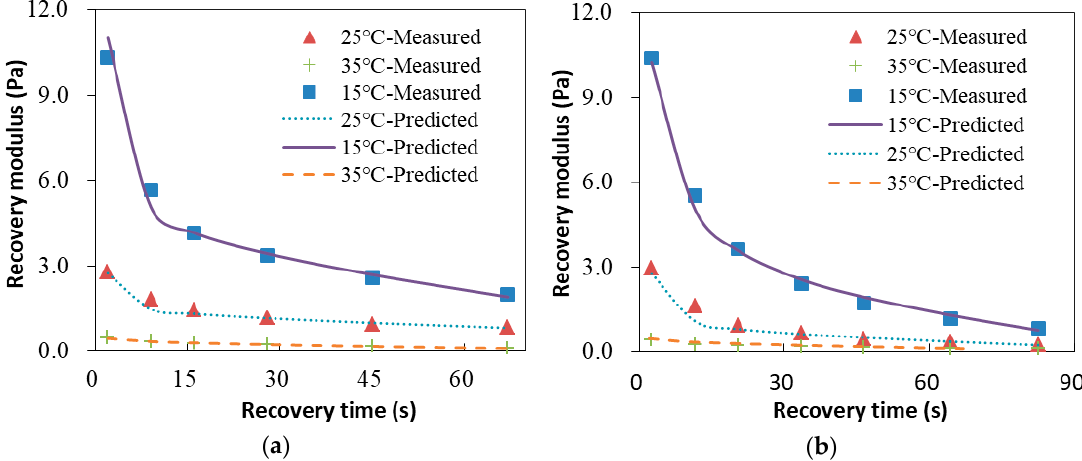
Figure 7. Recovery modulus for the base binder at 15 °C, 25 °C, and 35 °C. ( a ) Nondestructive CSR test; ( b ) Destructive CSR test.